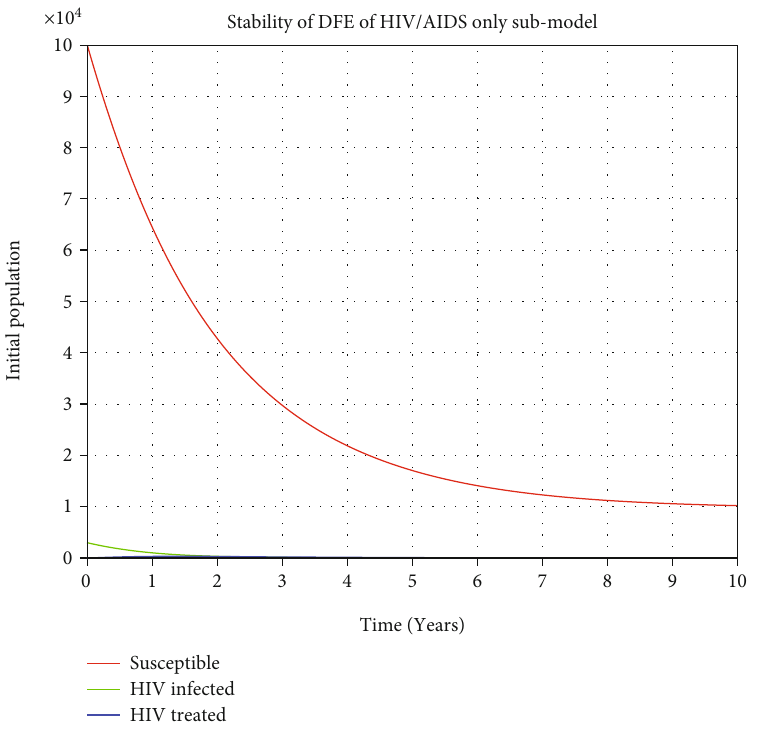
= 0 : 003 , ω = 0 : 003 , and μ = 0 : 5 . H 0